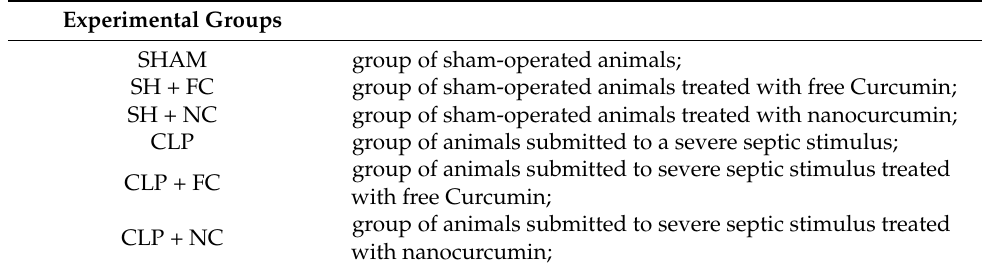
Table 1. Description of experimental groups. Experimental